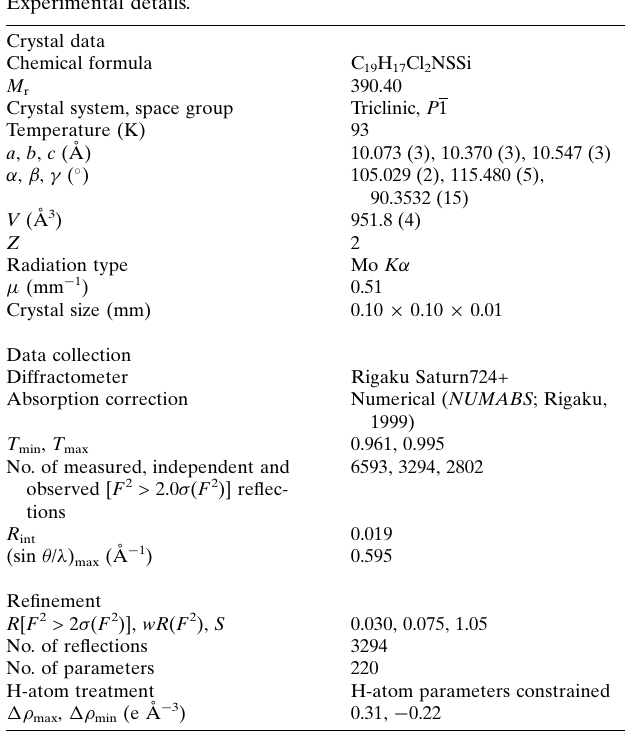
Table 2 Experimental details.